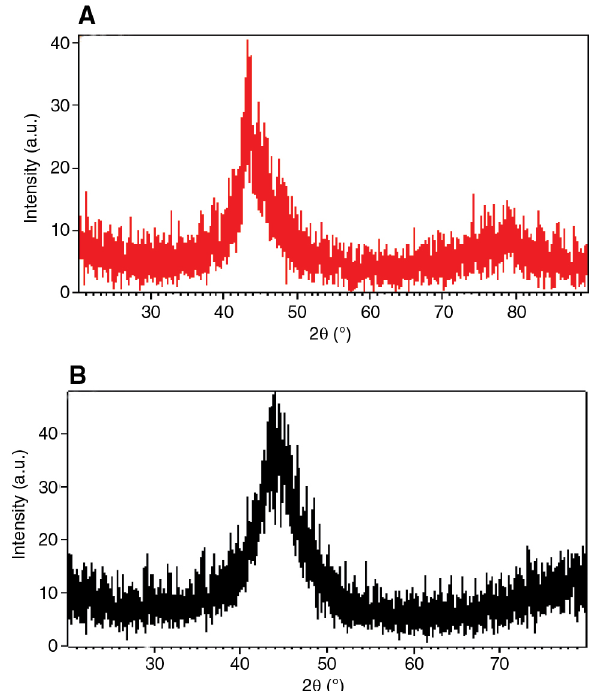
Figure 4: XRD pattern analysis of (A) powder and (B) coating.